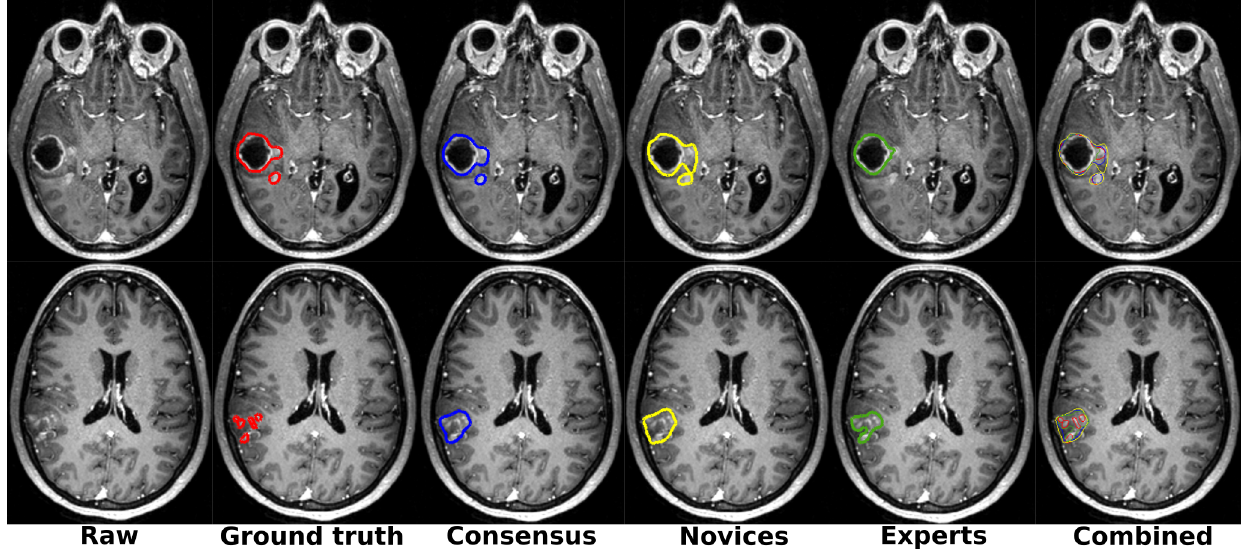
Figure 5. Illustration of the manual segmentation differences between the different raters, one patient per row. Color code: red is the ground truth; blue is the majority voting across all raters; yellow is the majority voting across novice raters; green is the majority voting across expert raters (best viewed digitally and in